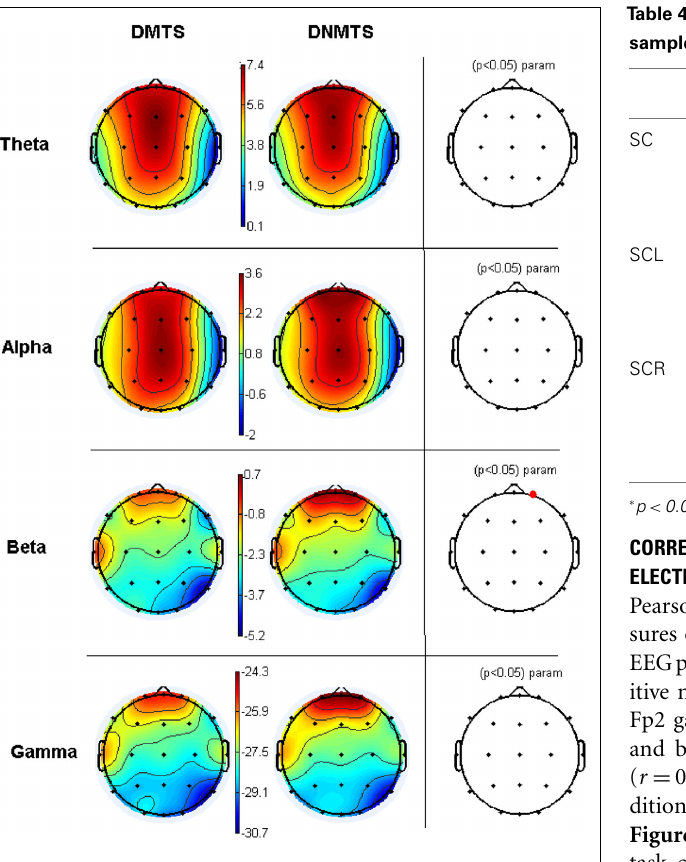
FIGURE 3 | Relative topographic power spectrum distribution for specified bands with each condition task, delayed matching to sample (DMTS) and delayed non-matching to sample (DNMTS), and statistical relevance related to tasks for each location. Theta activity – 4- to 8-Hz; Alpha activity – 8- to 13-Hz; Beta activity – 13- to 30-Hz; Gamma activity – 30- to 70-Hz. Red dot indicates significant difference ( p < 0.05) in electrode location. Table 3 | Mean ± SEM of HR values according to task condition.